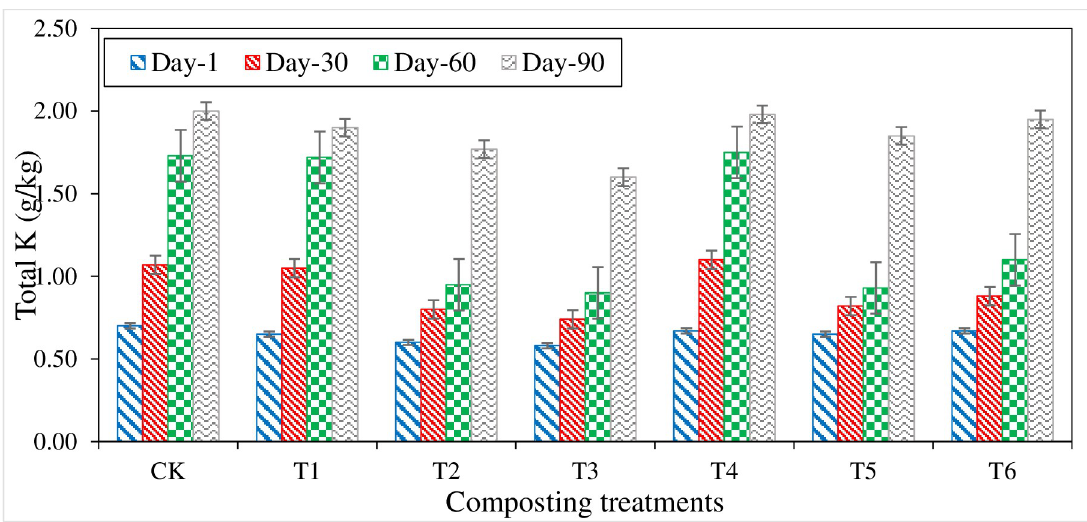
Fig 11. Variation in total potassium (K) measured from different composting